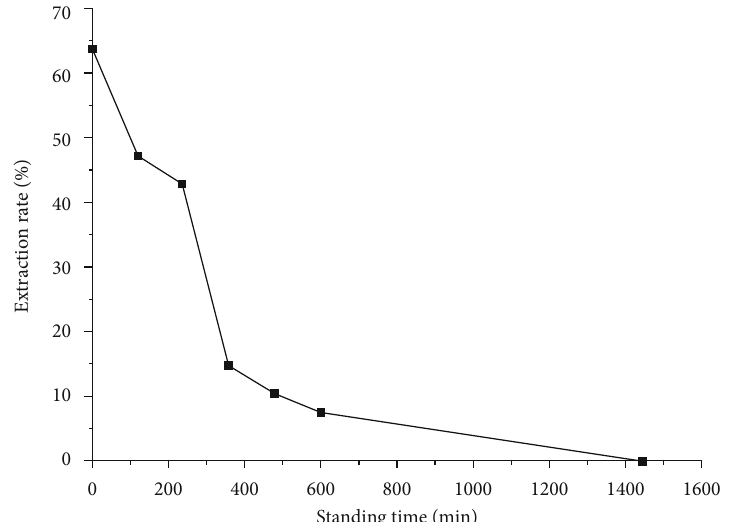
Figure 6: The e ff ect of the feed liquid standing time on the extraction rate.